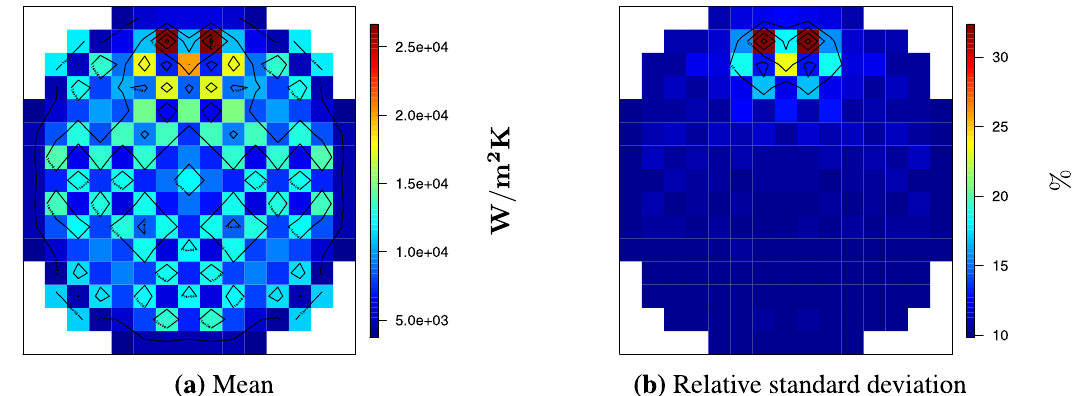
Fig. 16. H 3 D gap estimated mean and relative standard deviation in the radial cross-section for IBE UQ analysis.